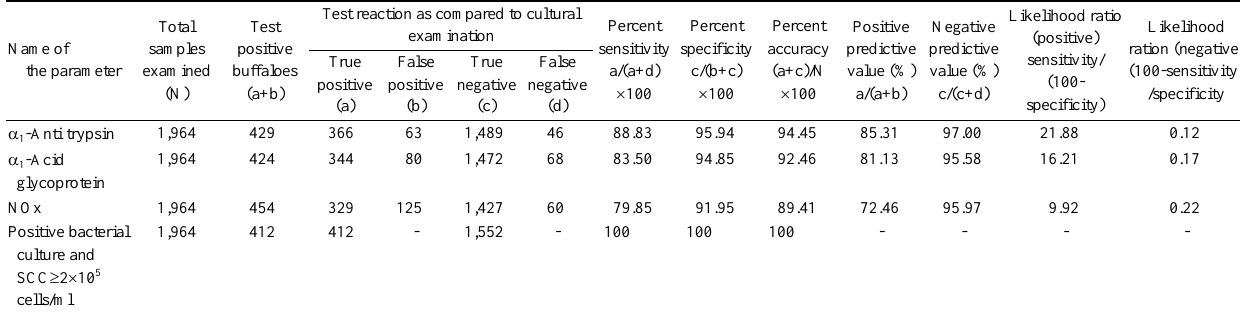
Table 5. Evaluation of  1 -anti trypsin,  1 -acid glycoprotein and NOx as an indicator for diagnosis of subclinical mastitis in riverine buffalo caused by gram positive bacteria only